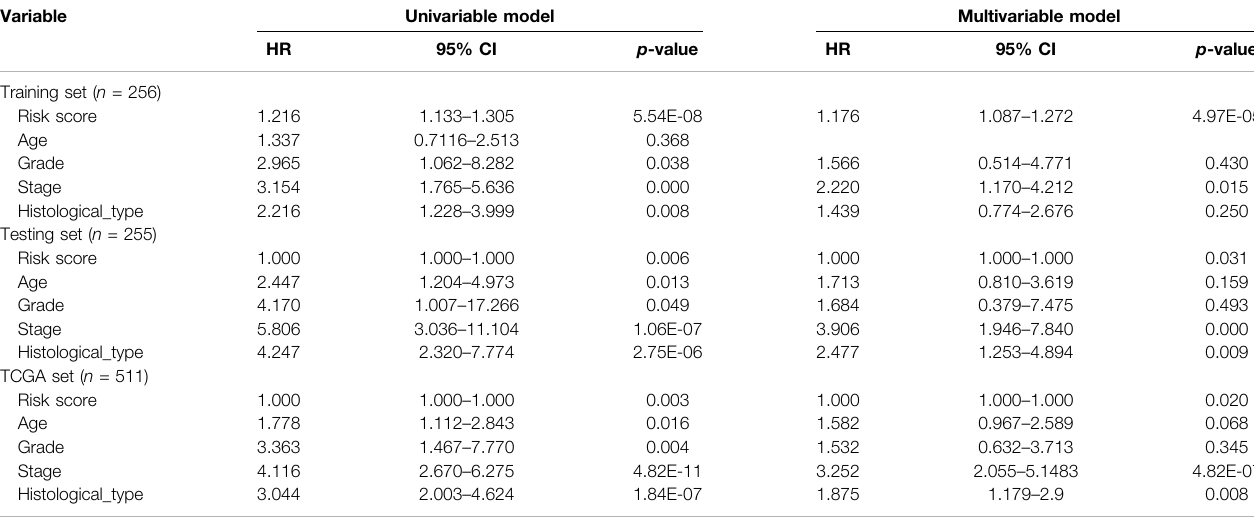
TABLE 2 | Univariate and multivariable Cox regression analysis of the GILnvSig and overall survival in different patient sets.